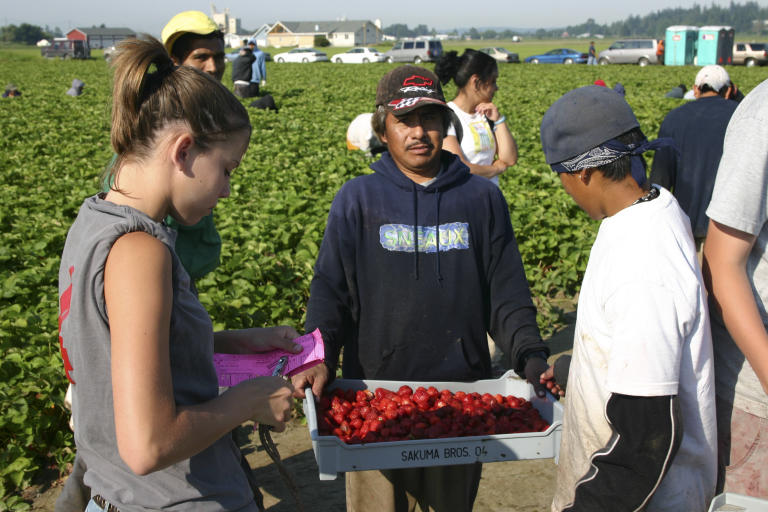
Teenage Checker Punches the Weight of Berries Brought in by a PickerA teenage checker punches the weight of berries brought in by a picker.